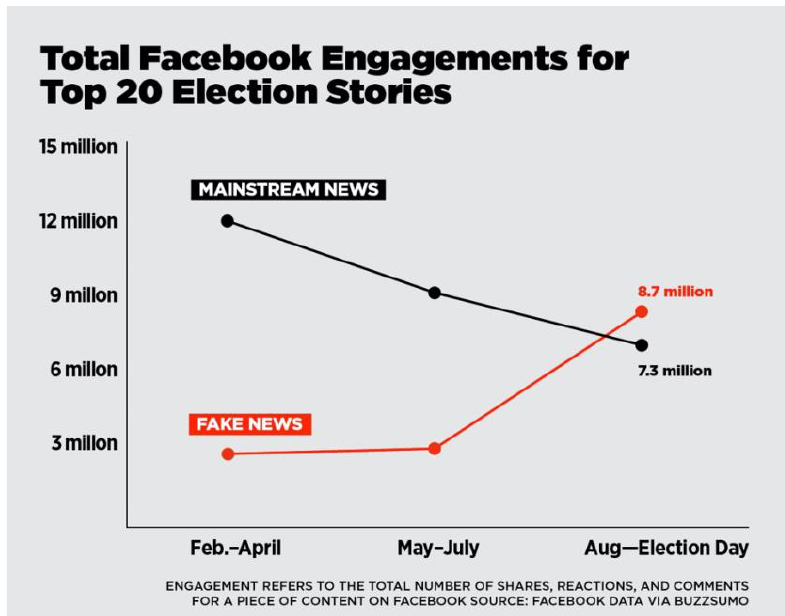
Figure 1. ‘Fake news’ outperforms mainstream news in the months prior to the 2016 US presidential elections. Source: Silverman, 2016.